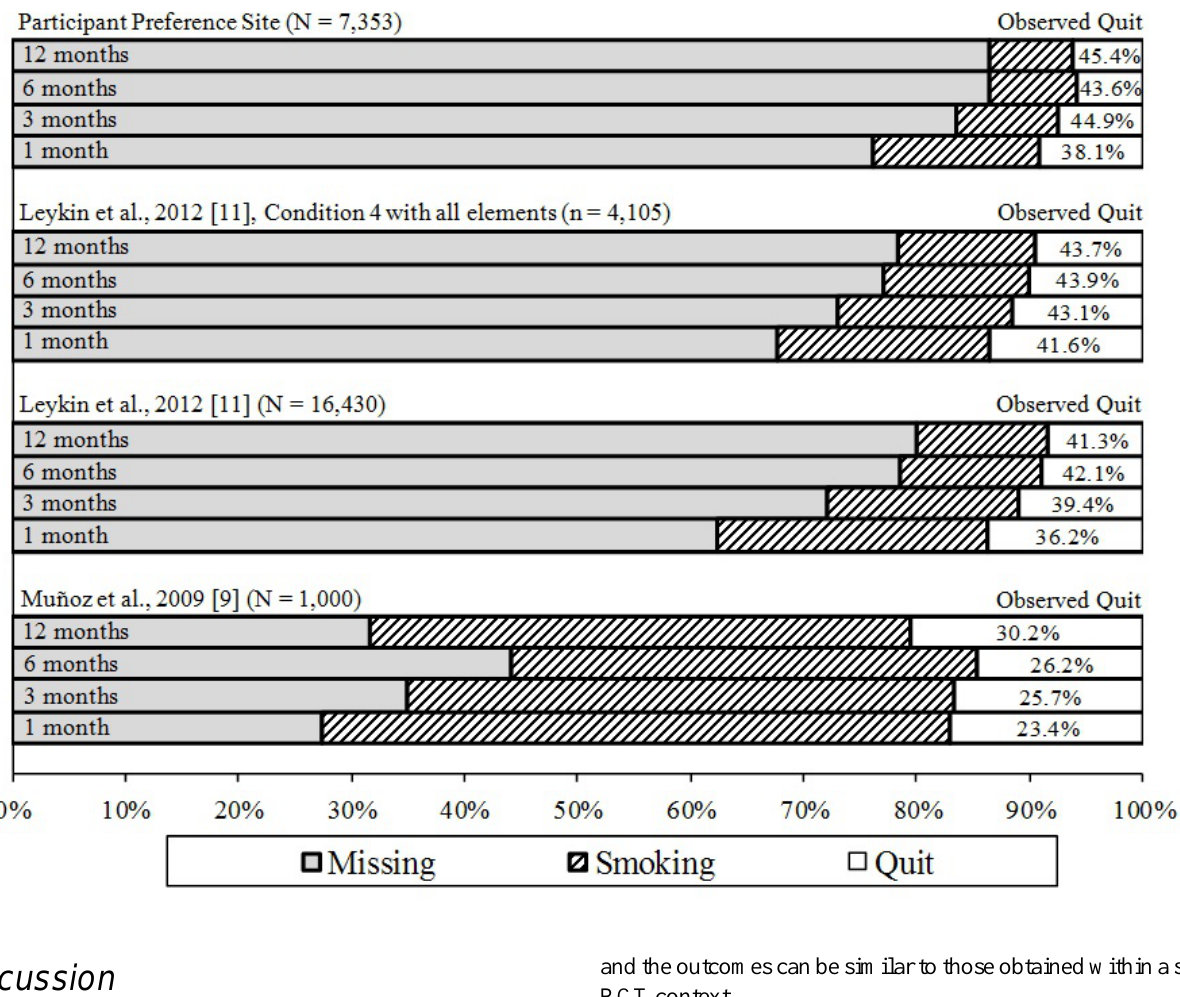
Figure 2. Observed quit rates by study for the San Francisco Stop Smoking participant preference study and previous randomized controlled trials (RCTs). The outcomes of the current participant preference site, as compared with the RCT with live cohort maintenance follow-up methods ([7], N = 1000), a fully automated RCT without live follow-up ([11], N = 16,430), and condition 4, the condition in that same automated RCT that included all site elements, which approximates the current site, but without the participant preference component ([11], n = 4105). Shaded areas indicate missing data. Observed Quit is defined as the number reporting not smoking divided by number reporting smoking status (smoking or not smoking). Thus, it does not impute values for missing